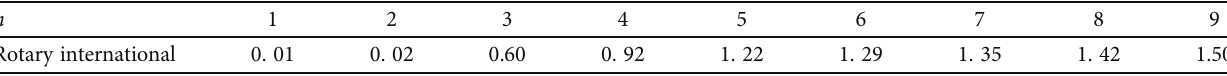
Table 3: Judgment matrix RI value